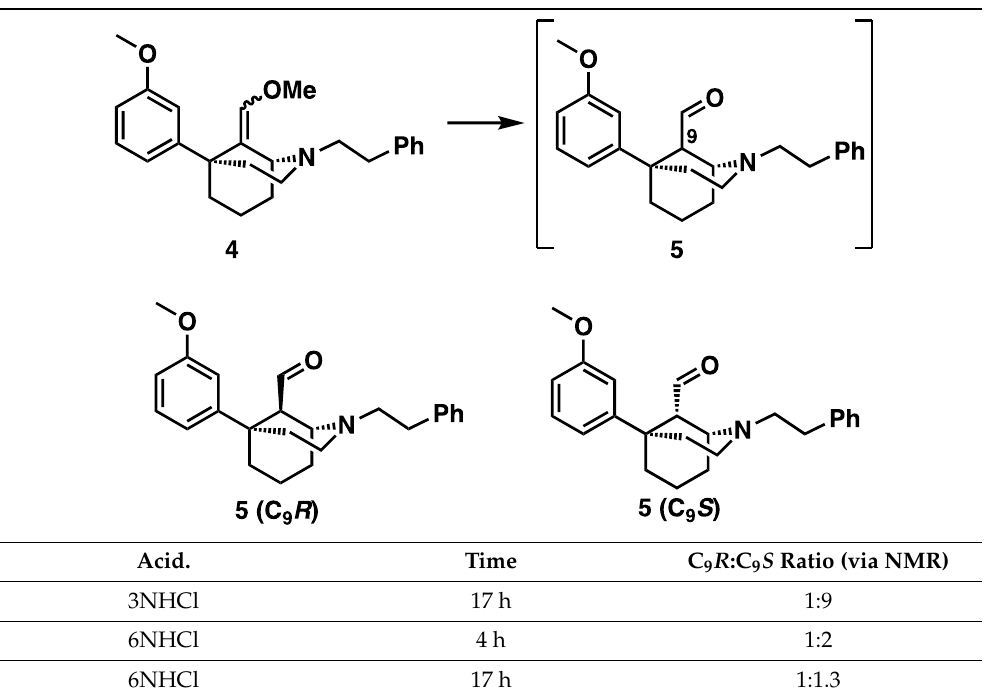
Table 1. Varying concentration and time of acid hydrolysis to give different ratios of epimeric products, as determined from NMR.